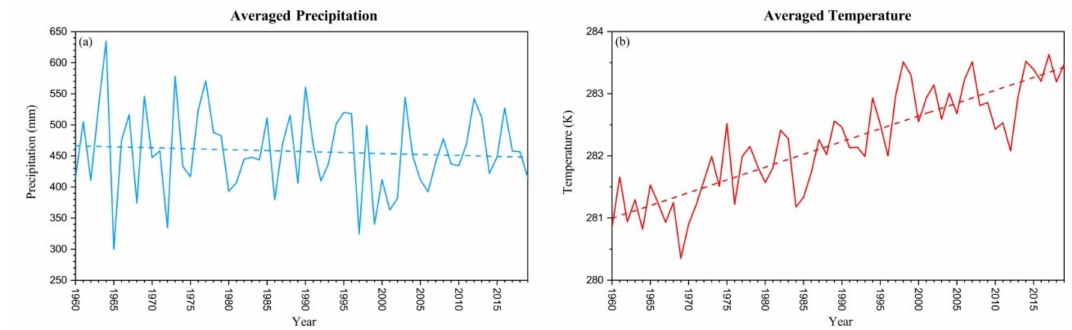
Figure 2. Variation of annual average precipitation ( a ) and average temperature ( b ) in North China from 1960 to 2019.